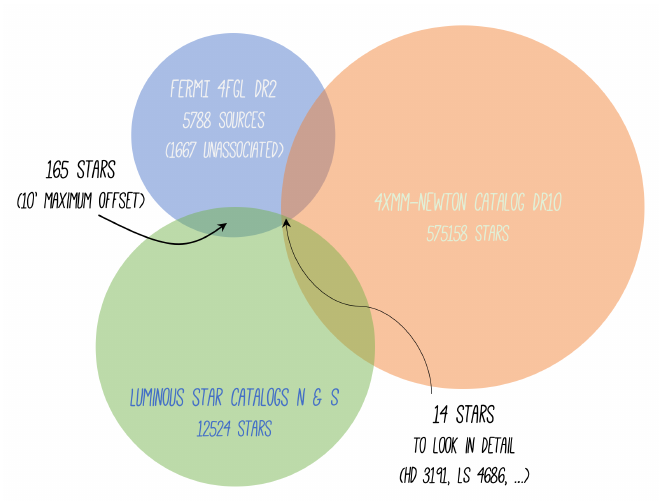
Figure 1. Sketch showing the multiple cross-identification procedure followed in this